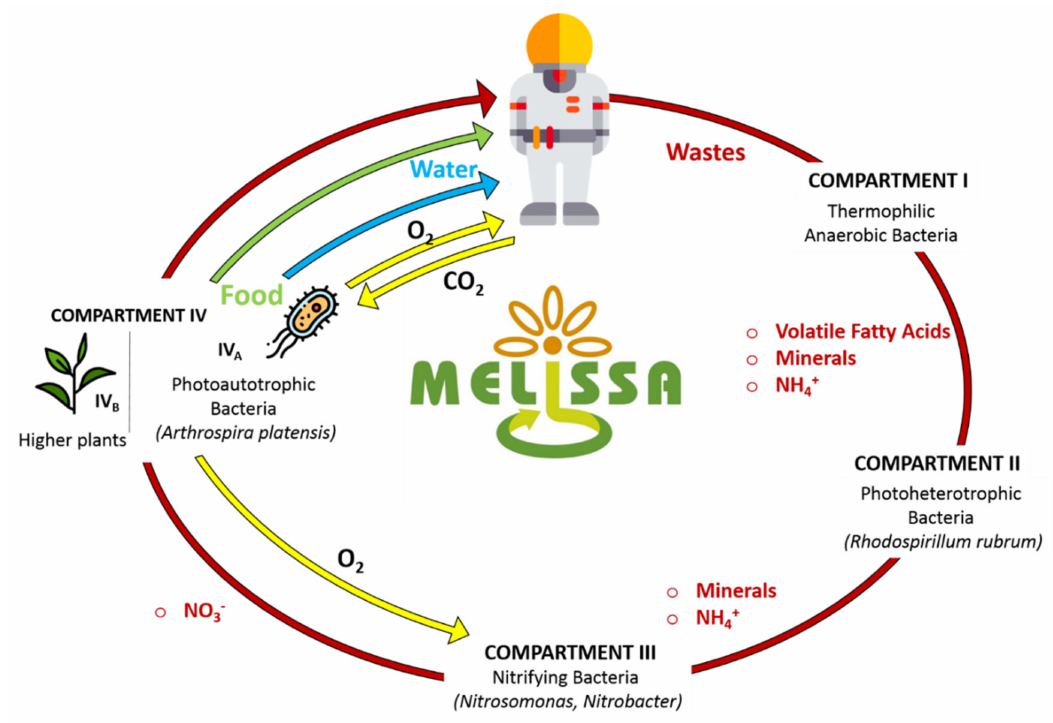
Figure 4. The Micro-Ecological Life Support System Alternative (MELiSSA) loop. Adapted from